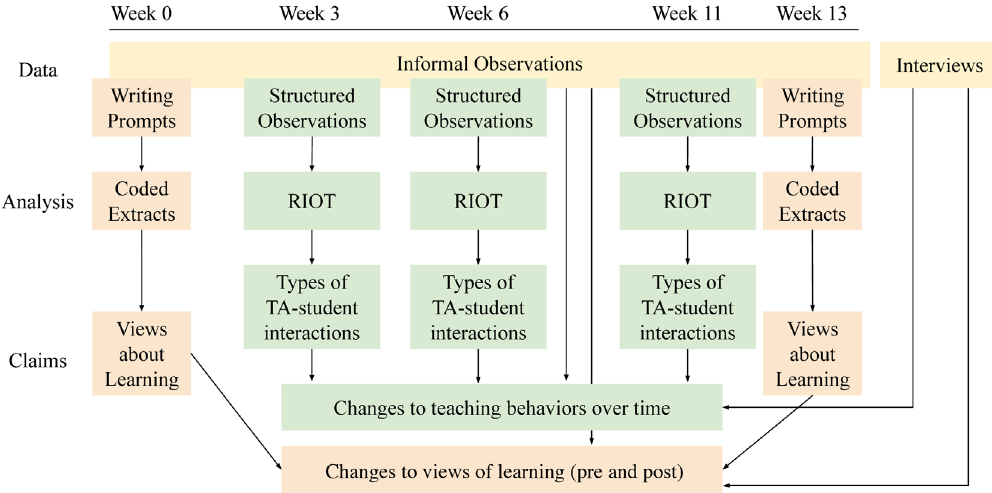
FIG. 2. Diagrammatic representation of data collection over the course of a typical